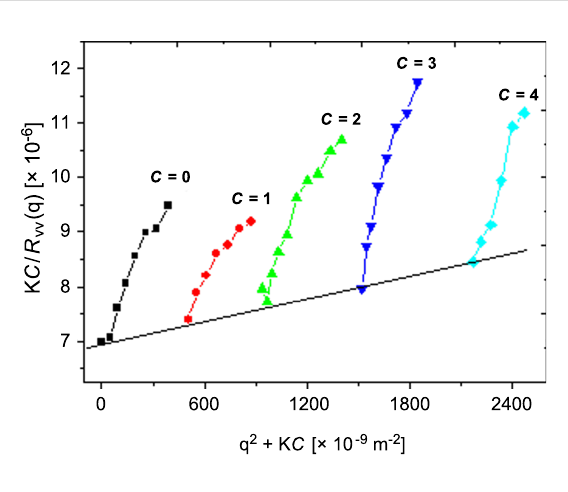
grams for polymers P1 and P2 are shown in Figure 4 and the results of the thermal analysis are shown in Table 1. For DSC, the samples were first heated to melting, then cooled to the glassy state and reheated to determine the glass transition temperature ( T g ). A representative DSC graph is shown for P1a in Figure 5. T g is calculated from the second heating curve. As it can be seen from the graph, T g for the polymer is 154 °C. All the polymers show glass transition temperatures above 150 °C (Table